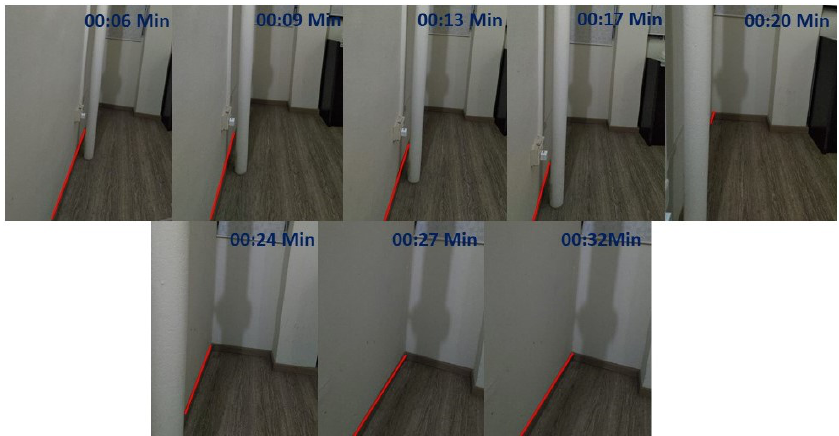
Figure 22. Series of image from the hsr robot during the trial with embedded time scenario 2.